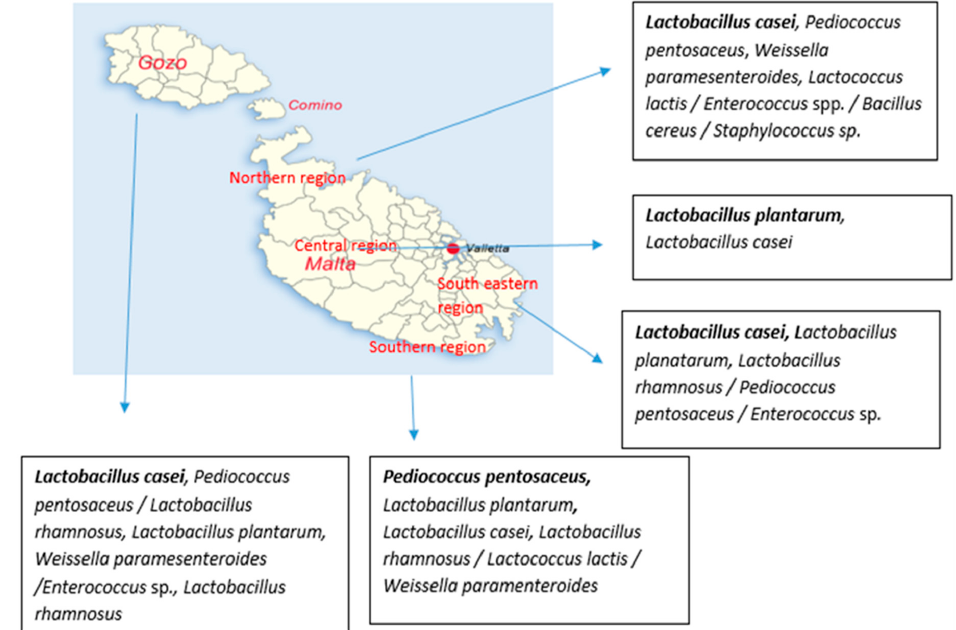
Figure 4. Geographical distribution of isolates at species level from Maltese raw milk recovered from LSA medium during winter period. The species are written from the most commonly detected to fairly detected ones; bold fonts represent the most commonly detected species while the “/” was used to separate the species that were detected in the same number. Microorganisms 2020 , 8 , x FOR PEER REVIEW